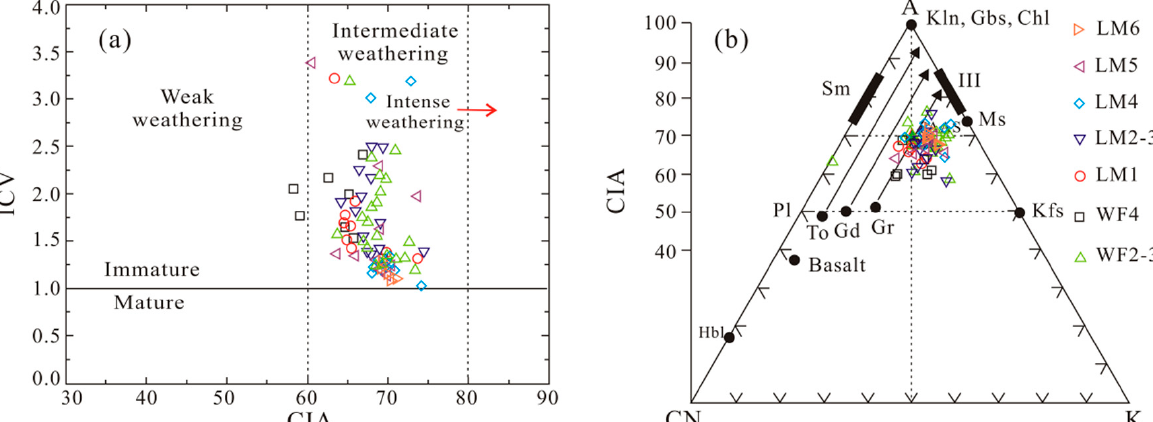
Figure 14. ( a ) Index of compositional variability (ICV)–chemical index of alternation (CIA) diagram. ( b ) A–CN–K (Al 2 O 3 − [CaO* + Na 2 O] − K 2 O) diagram. Data for tonalite (To), granodiorite (Gd), granite (Gr), and post–Archean Australian shales are from [45]. Arrowheads show the predicted weathering trends. Chl = chlorite; Gbs = gibbsite; Hbl=hornblende; III = illite; Kfs = potassic feldspar; Kln = kaolinite; Ms = muscovite; Pl = plagioclase; Sm = smectite.